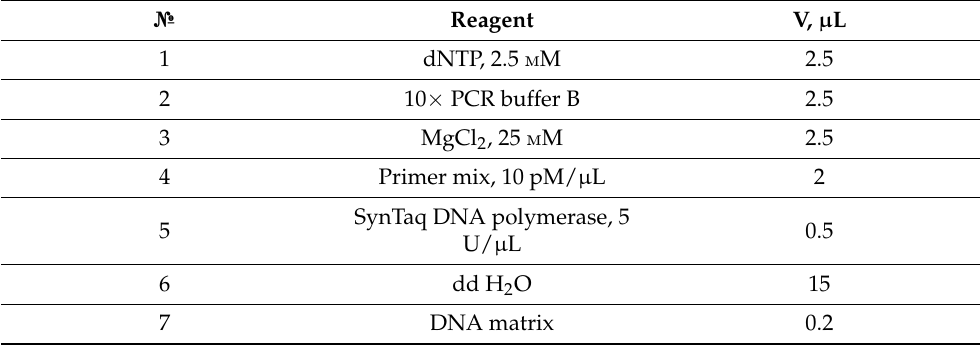
Table 2. PCR mix